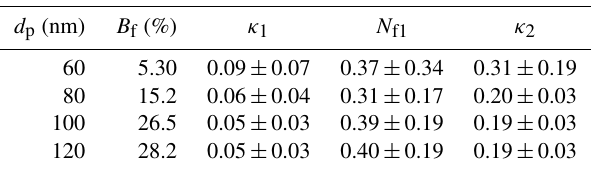
Table 4. Same as Table 3, during the Euboea event (3–5 Septem- ber